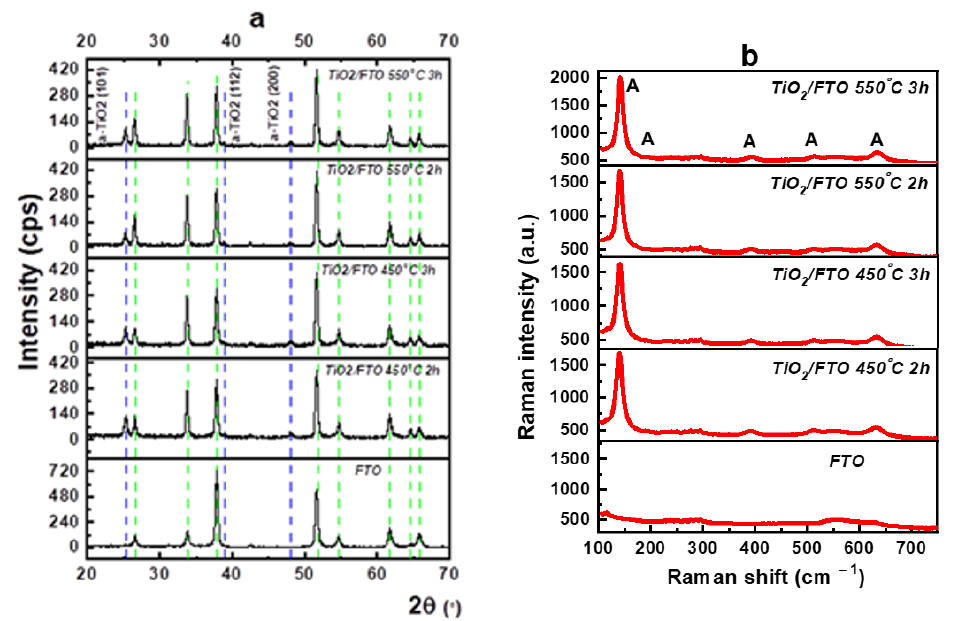
Figure 1. Structural characterization of TiO 2 films on FTO substrate after calcination at 450 ◦ C and 550 ◦ C for 2 h and 3 h. ( a ) XRD patterns and ( b ) Raman spectra, indicating the formation of pure anatase titania polymorph.